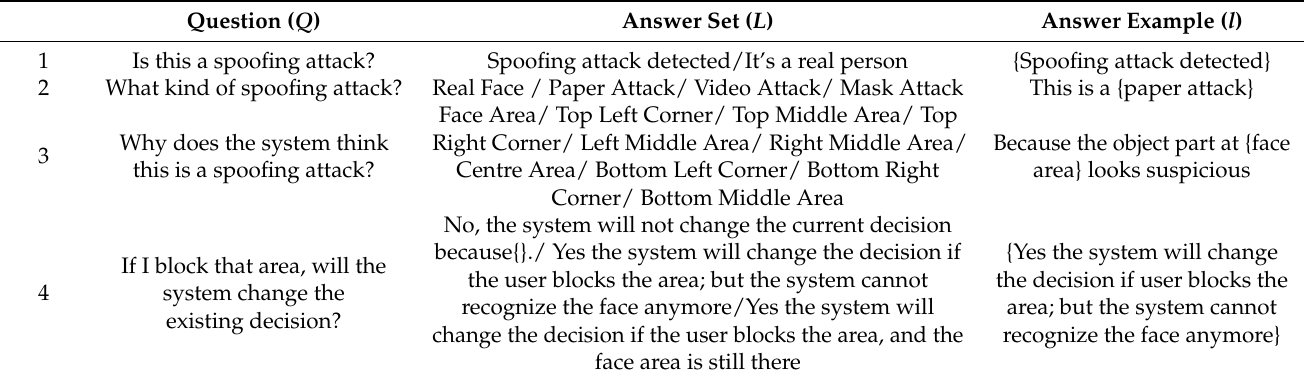
Table 1. Example of Question and Answering